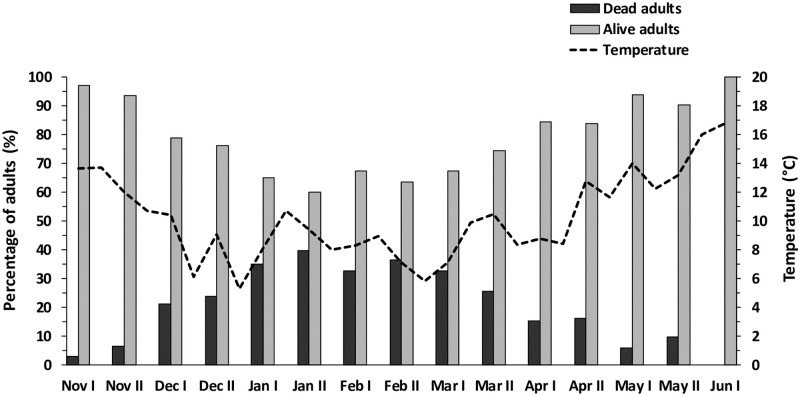
Mortality of Xylosandrus compactus overwintering adults inside carob twigs in Sicily (Southern Italy).Mean percentage of live and dead adults found infesting the sampled carob twigs. The dashed line represents the mean minimum temperatures of the period.